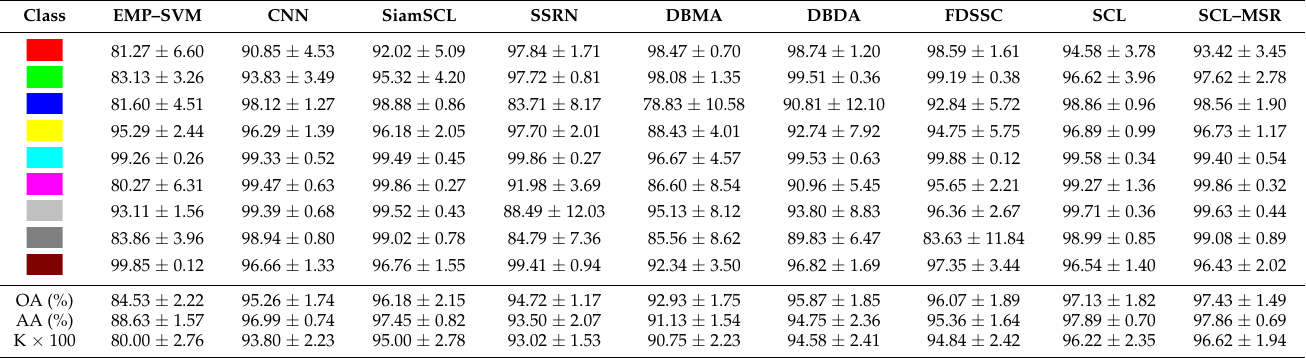
DBDA by 0.69 percentage points, 11.39 percentage points, and 0.00074 in terms of OA,